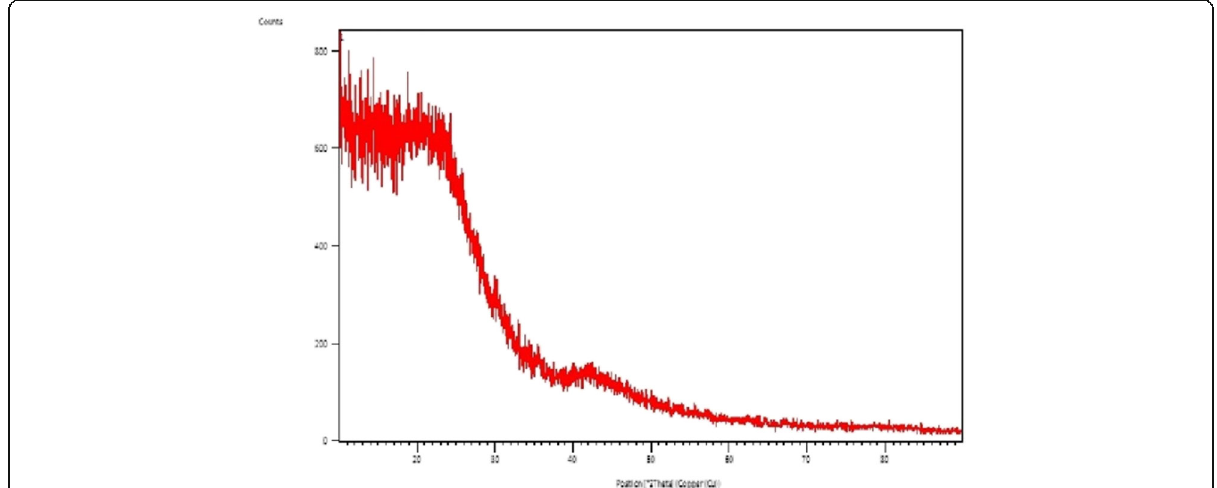
Fig. 4 XRD spectra of zinc